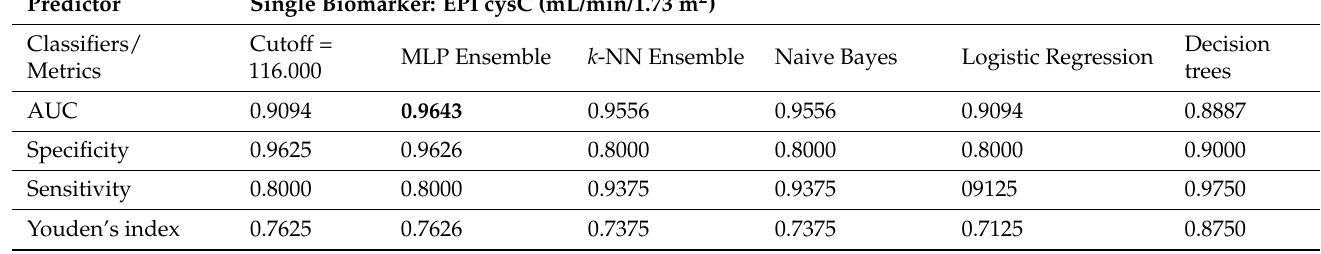
Table 3. The diagnostic performance of t six classifiers for CRS by using a single predictive variable: GFR of biomarker EPI cysC (mL/min/1.73 m 2 ). Metrics of performance are: AUC, specificity, sensitivity and Youden’s